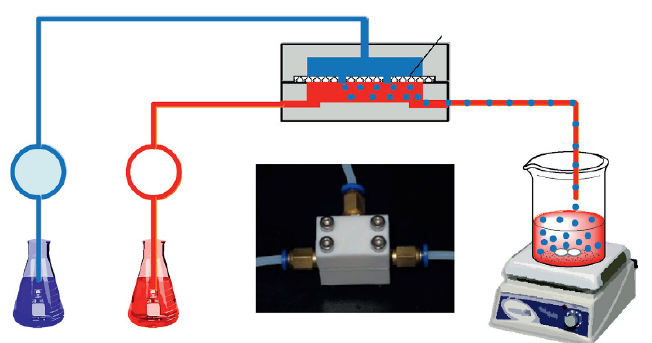
Figure 5. Description of Ca(II)–CS microsphere preparation. Reproduced from the work in [53] with permission from Elsevier. permission from